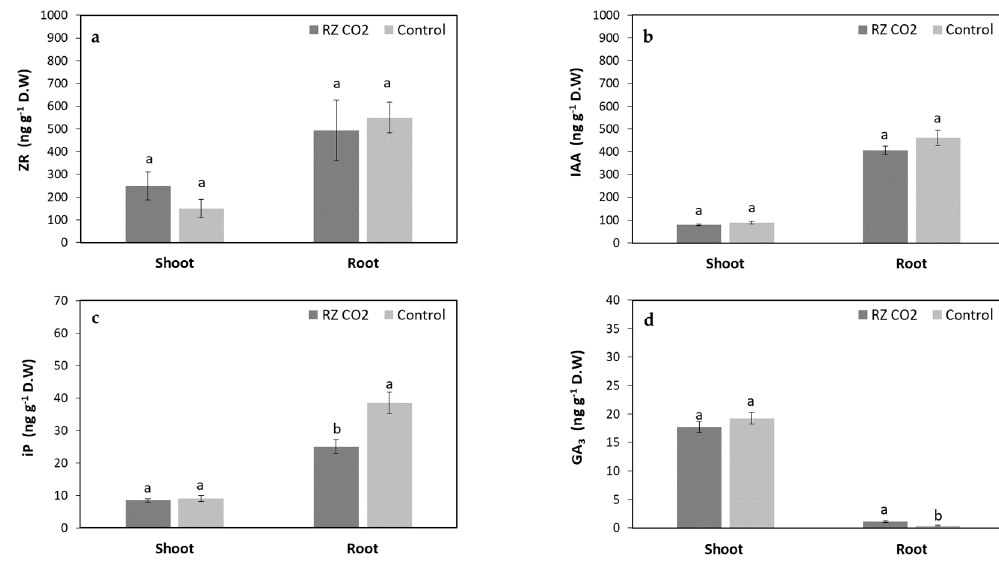
Figure 2. Pepper leaf and root zeatin riboside (ZR) ( a ), indole-3-acetic acid (IAA) ( b ), isopentenyl adenosine (iP) ( c ) and gibberellic acid (GA 3 ) ( d ) phytohormone (and precursor) concentrations under high RZ CO 2 and ambient CO 2 . Bars are the mean ± SE of eight replicates, with different letters indicating significant ( p < 0.05) differences between treatments.